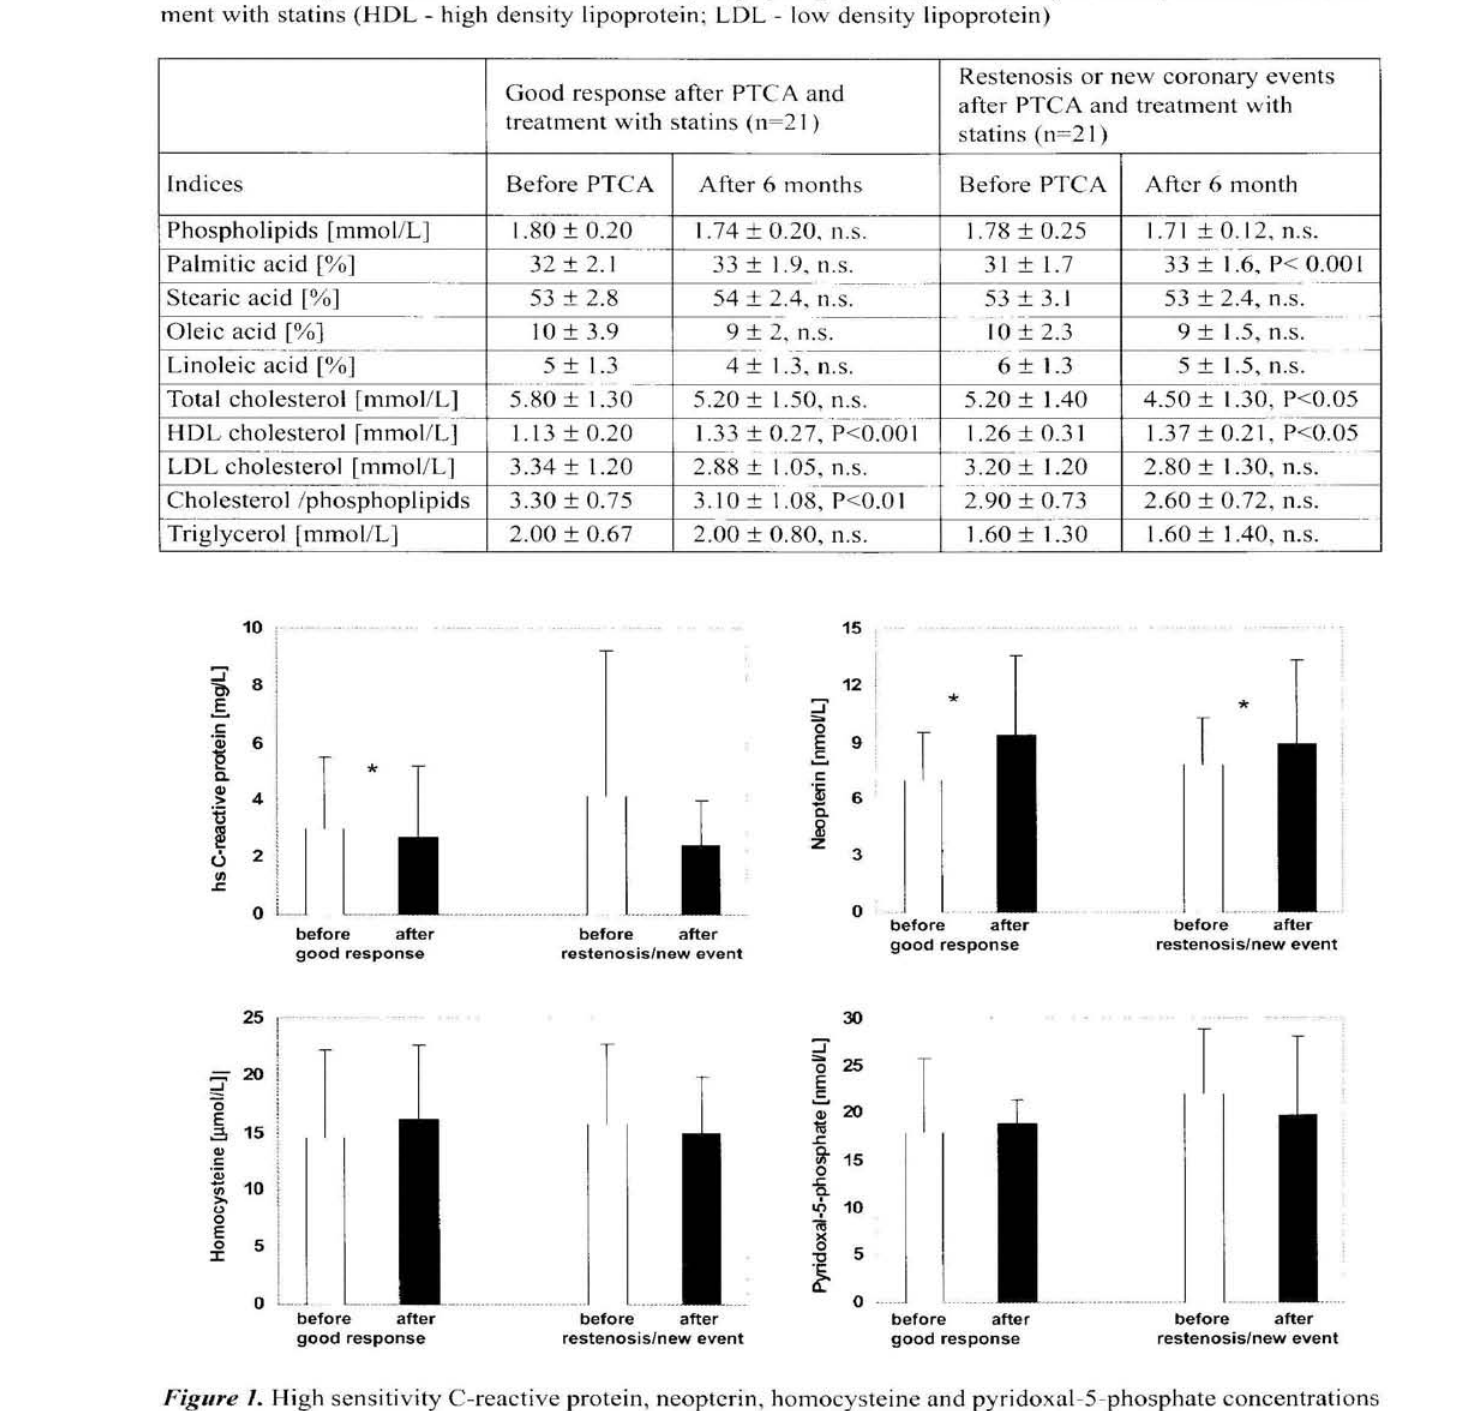
Table 2. Indices of inflammation and other risk factors in patients with coronary artery disease (CAD) before and 6 months after percutaneus transluminal coronary angioplasty (PTCA) followed by stent implantation and treat- ment with statins (HDL - high density lipoprotein; LDL - low density lipoprotein) Good response after PTCA and